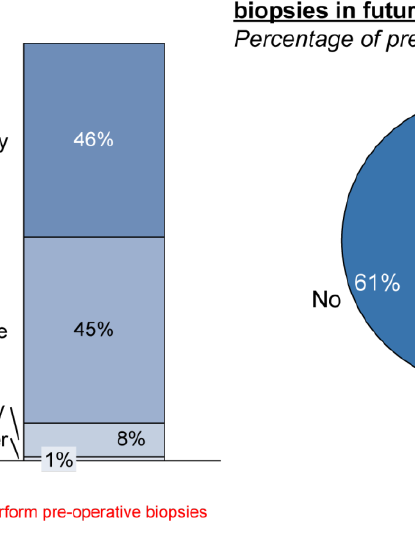
Figure 10. Pre-op kidney biopsy practitioners today and in the